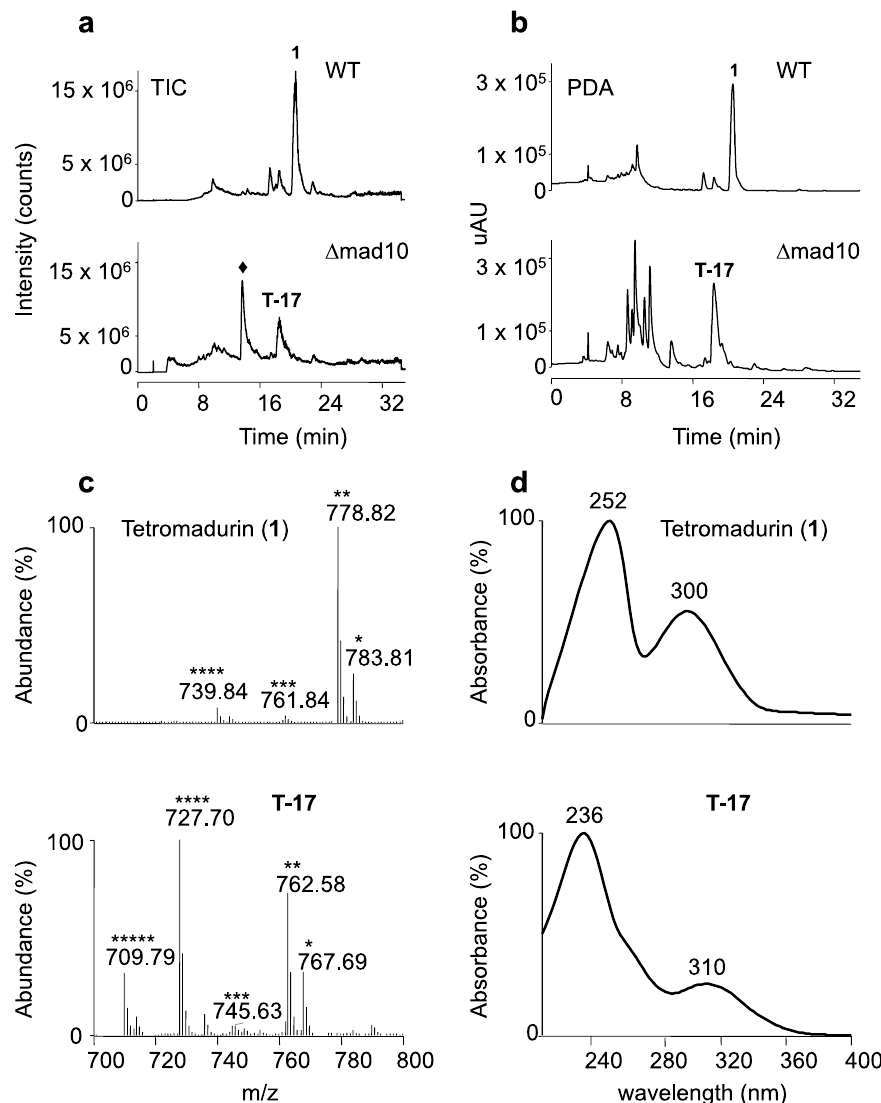
Fig 8. Novel tetromadurin analogue produced by A . verrucosospora Δ mad10. a, Total ion current (TIC) spectra of the crude organic extracts from A . verrucosospora wild type (WT) and A . verrucosospora Δ mad10. The other peaks represent unrelated species. Tetromadurin ( 1 ) was produced by A . verrucosospora and eluted at 19.8 min. A novel tetromadurin-related metabolite (named T-17) was produced by A . verrucosospora Δ mad10, eluting at 17.4 min. b, HPLC-PDA (photodiode array) spectra of the crude organic extracts from A . verrucosospora WT and A . verrucosospora Δ mad10. c, Positive ion mode mass spectrum of tetromadurin ( 1 ) and T-17: � [M+Na] + , �� [M+NH4] + , + , ����� [M+H − 2.H + . For tetromadurin ( 1 ): m/z [C + = 783.81; m/z ��� [M+H + , ���� [M+H − H 2 O] 2 O] 42 H 64 O 12 +Na] [C 42 H 64 O 12 +NH 4 ] + = 778.82; m/z [C 42 H 64 O 12 +H] + = 761.84; m/z [C 42 H 64 O 12 +H − H 2 O] + = 739.84. For T-17: m/z [C 42 H 64 O 11 +Na] + = 767.69; m/z [C 42 H 64 O 11 +NH 4 ] + = 762.58; m/z [C 42 H 64 O 11 +H] + = 745.63; m/z [C 42 H 64 O 11 +H − H 2 O] + = 727.70; m/z [C 42 H 64 O 11 +H − H 2 O] + = 727.70; m/z [C 42 H 64 O 11 +H − 2.H 2 O] + = 709.79. d, UV absorption spectra of tetromadurin ( 1 ) ( λ max = 252 nm, 300 nm, MeOH) and T-17 ( λ max = 236 nm, 300 nm, MeOH). The ♦ indicates an unrelated compound that is also detectable in the WT